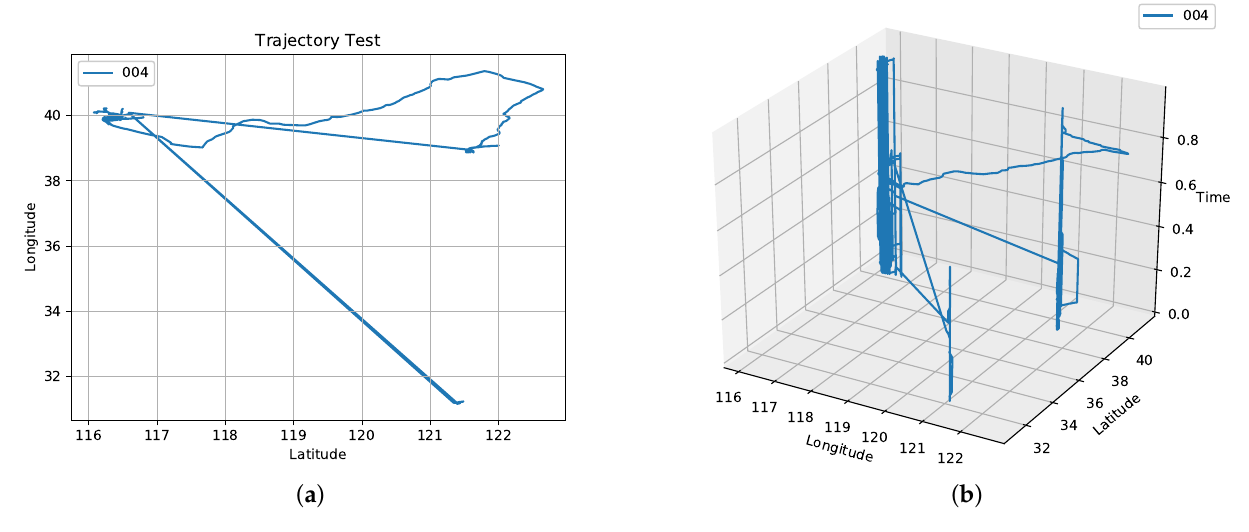
Figure 2. Trajectories of user [004] from 23 October 2008 to 5 July 2009. ( a ) Two-dimensional trajectory; ( b ) three-dimensional